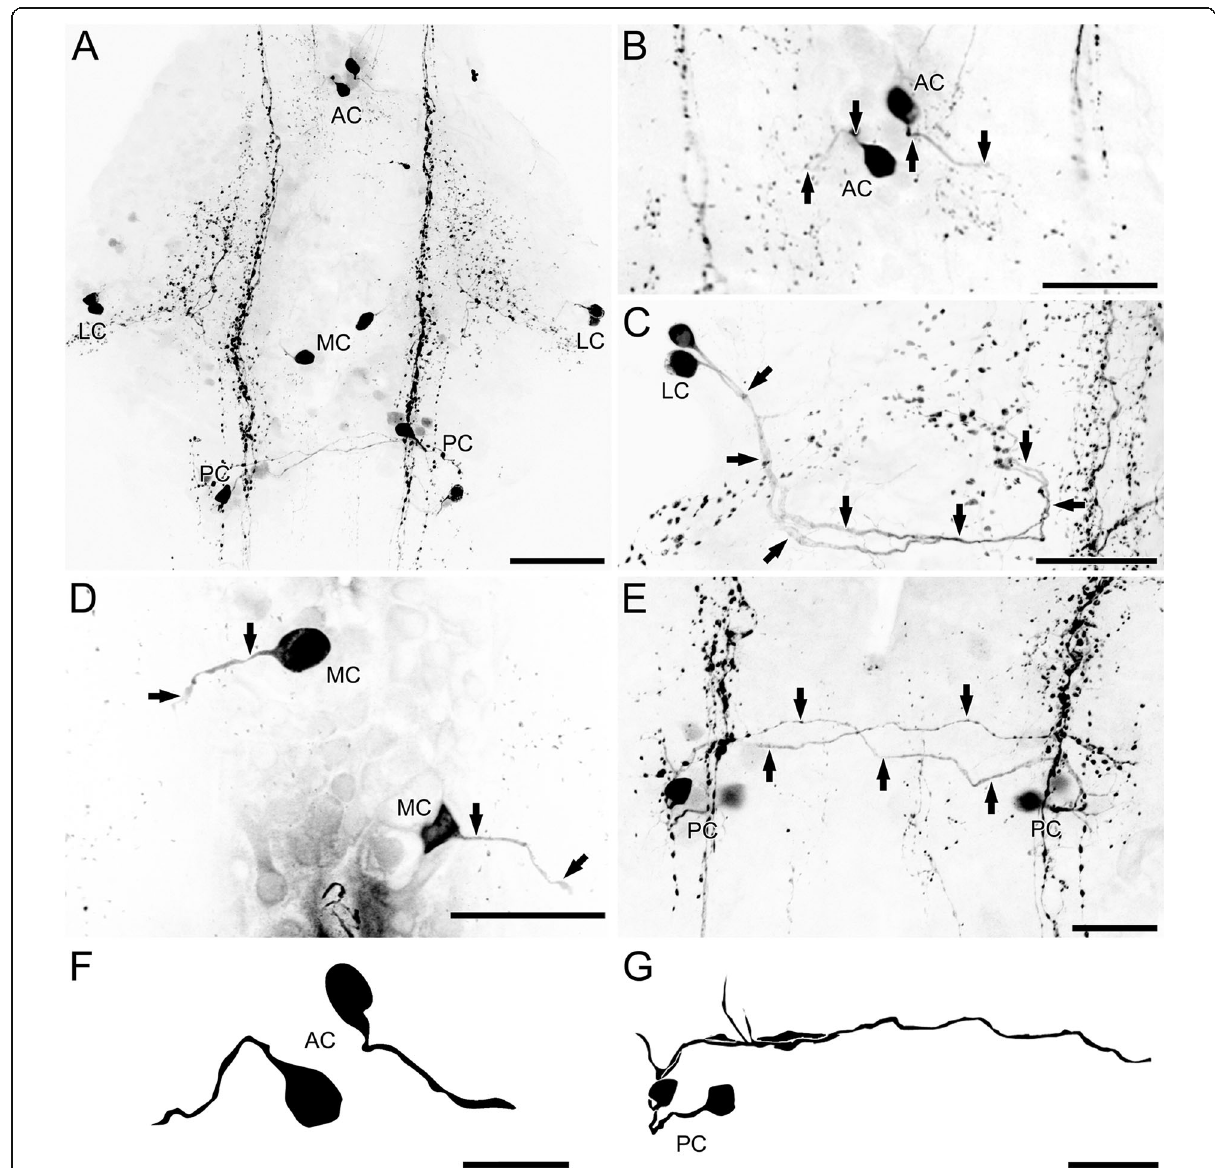
Fig. 4 Distribution of 5HT-ir neurons in the VNC of Lithobius forficatus . All neurons were detected in every ganglion of all preparations. a These individually identifiable neurons are distinguished according to somata positions within the ganglia into anterior (AC), lateral (LC), medial (MC), and posterior cells (PC). b The AC projected their neurites contralaterally (arrows). c The LC project their neurites slightly posteriorly and medially towards the midline, and turn anteriorly again before the microscopic signal got lost (arrows). d Neurites of the medial cells could only be traced for a short distance (arrows), projecting laterad. e The pair of PCs project their processes contralaterally (arrows). f Reconstructions of ACs. g Reconstructions of PCs. Compare also Fig. 6. Scale bars: A = 100 μ m; B – E, G = 50 μ m; G = 25 μ